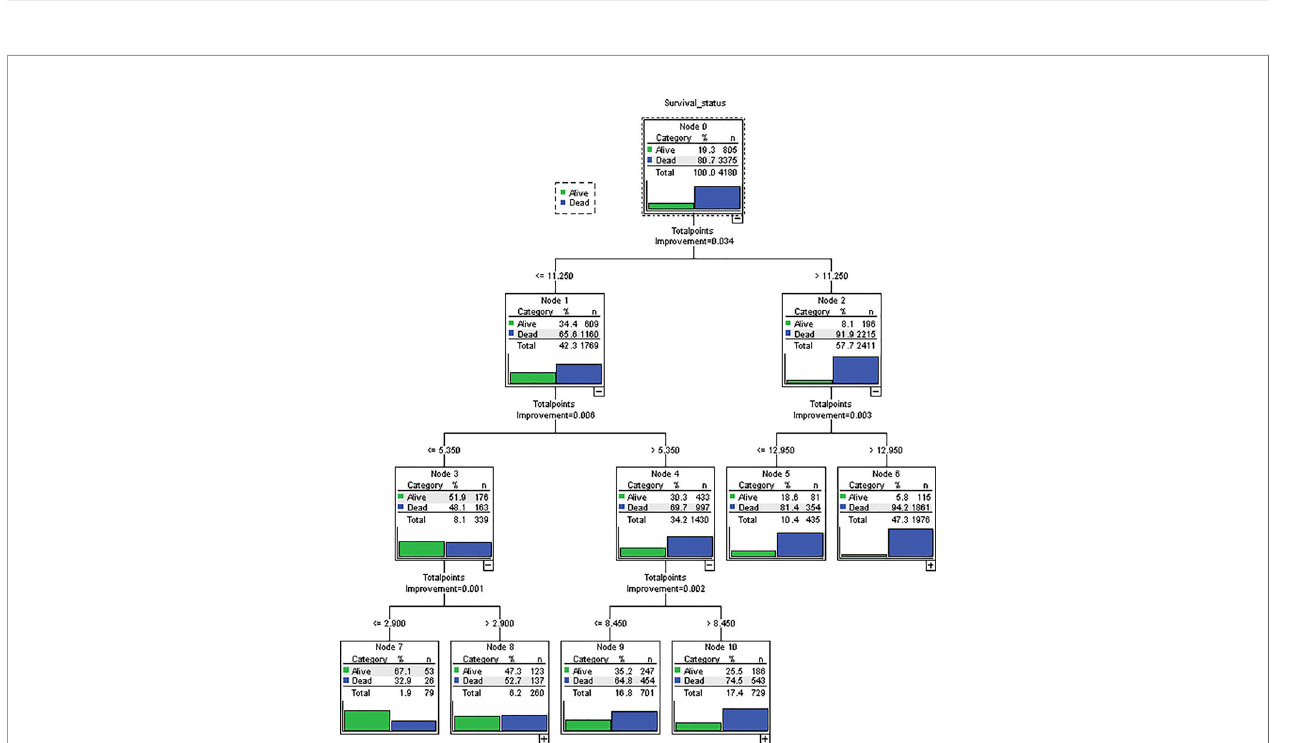
FIGURE 3 | Novel risk grouping method based on individual prognostic sum-scores. Cutoff values were determined by constructing classi fi cation and regression tree (CART) models. We grouped patients into 6 risk groups. (0-2.90; 2.90-5.35; 5.35-8.45; 8.45-11.25; 11.25-12.95; > 12.95).